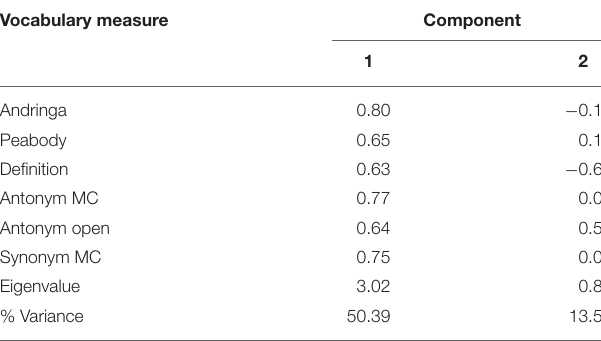
TABLE 7 | Results of the Principal Component Analysis assuming two